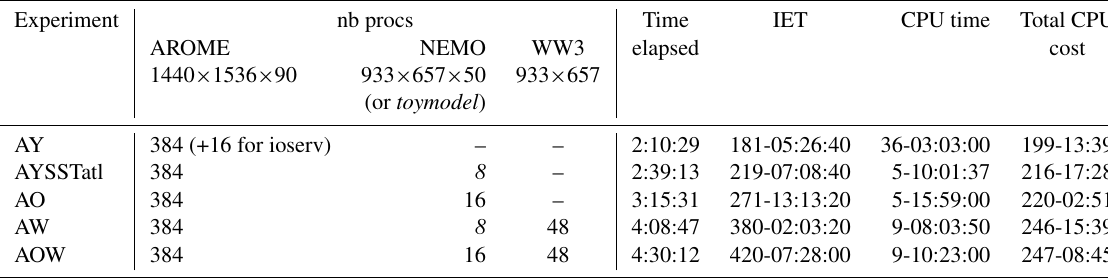
Table B1. Computation scaling on Météo-France HPC for a 42h-range forecast. Experiment nb